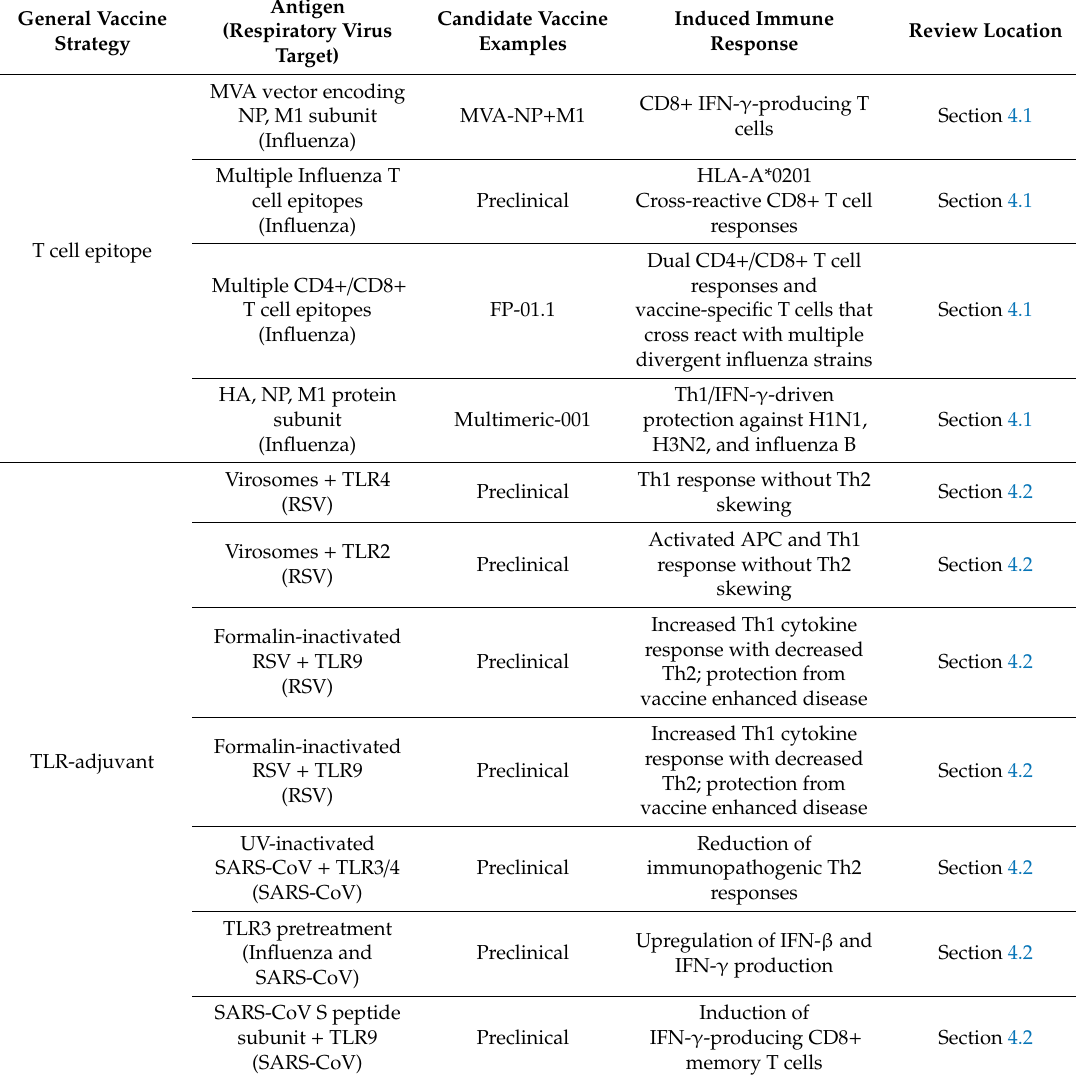
Table 1. Overview of Vaccination